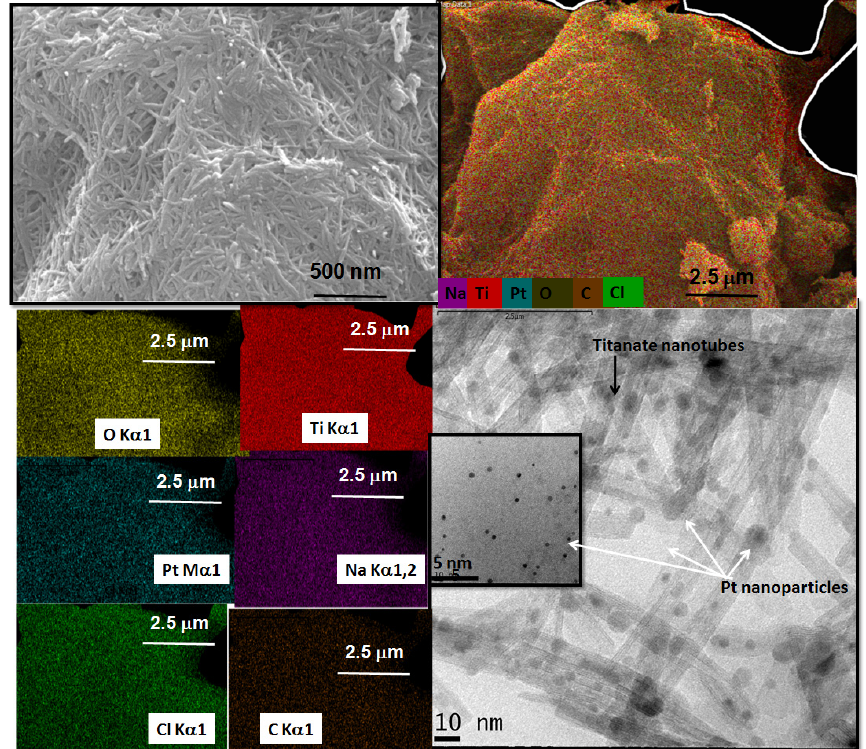
Figure 11. SEM-EDS and TEM images of PtNT spent titanate nanotubes catalyst characterizations. Reaction conditions: amount of the catalyst, 0.15 g; reaction gas mixture, 500 ppm of NO, 1000 ppm of CO and balance in He; flow rate, 80 mL·min − 1 ; space velocity, 48,000 h − 1 . Either 10 wt% (v/v) of water vapor or 50 ppm of SO 2 (or both) was used during the reaction at 250 °C for 6 h.